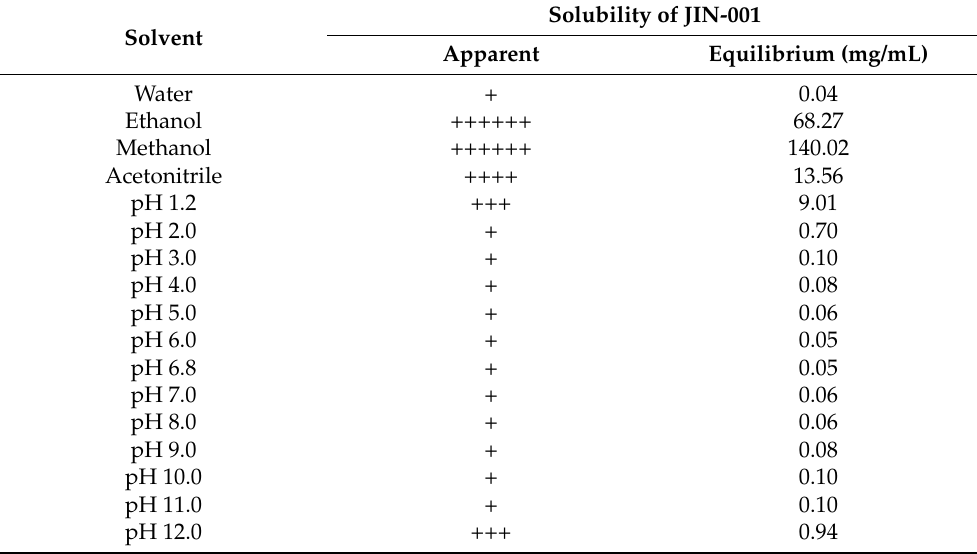
Table 2. The solubility of JIN-001 in various solvents.